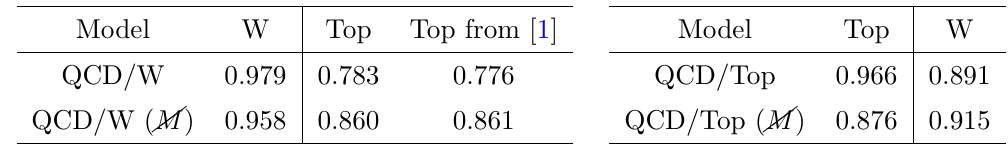
Table 1 . OoD detection performance in AUC for a (mass-decorrelated — (cid:26)(cid:26) M ) binary jet classifier with − p QCD as the anomaly score. Left : QCD/W classifier tested on Top; Right : QCD/Top classifier tested on W.